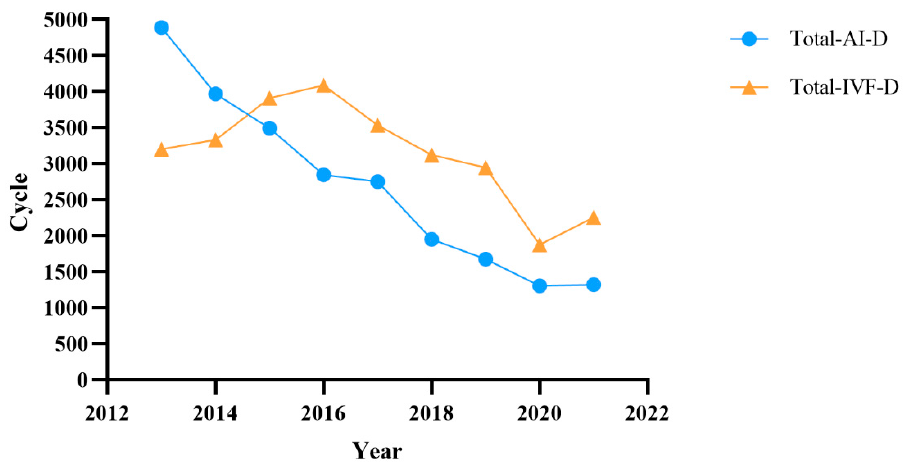
Figure 1. Total cycle changes of IVF-D and AI-D treatments.